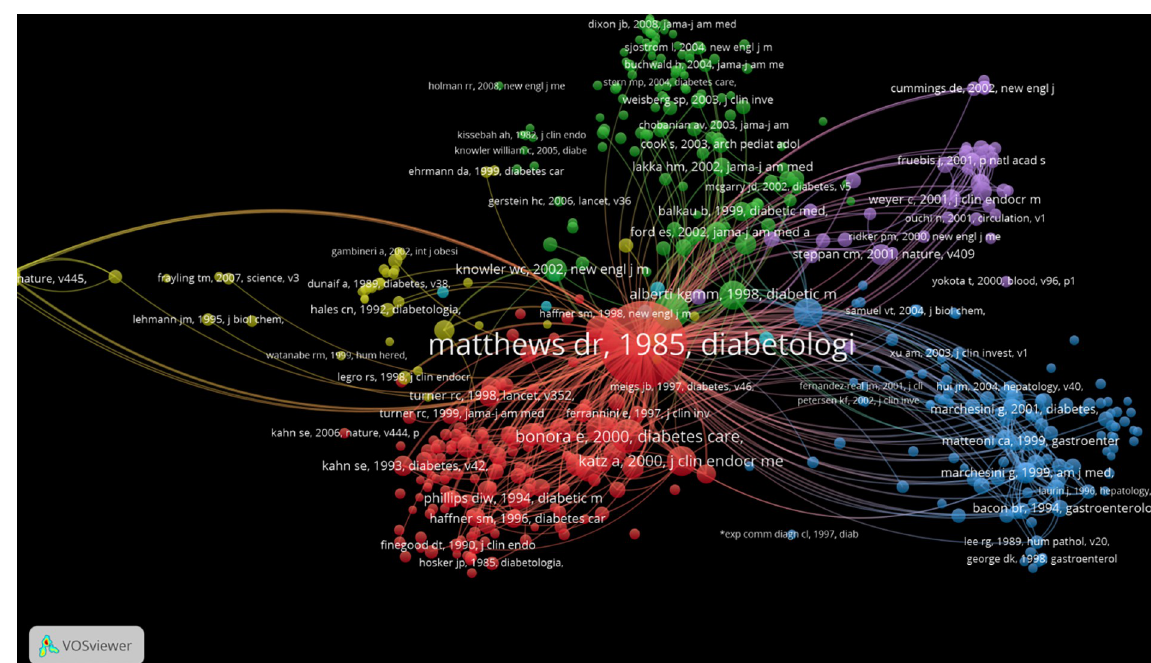
Fig 25. Co-citation map of the 500 most highly cited papers that cite the Matthews et al SB-SNPR (co-citation threshold = 3).